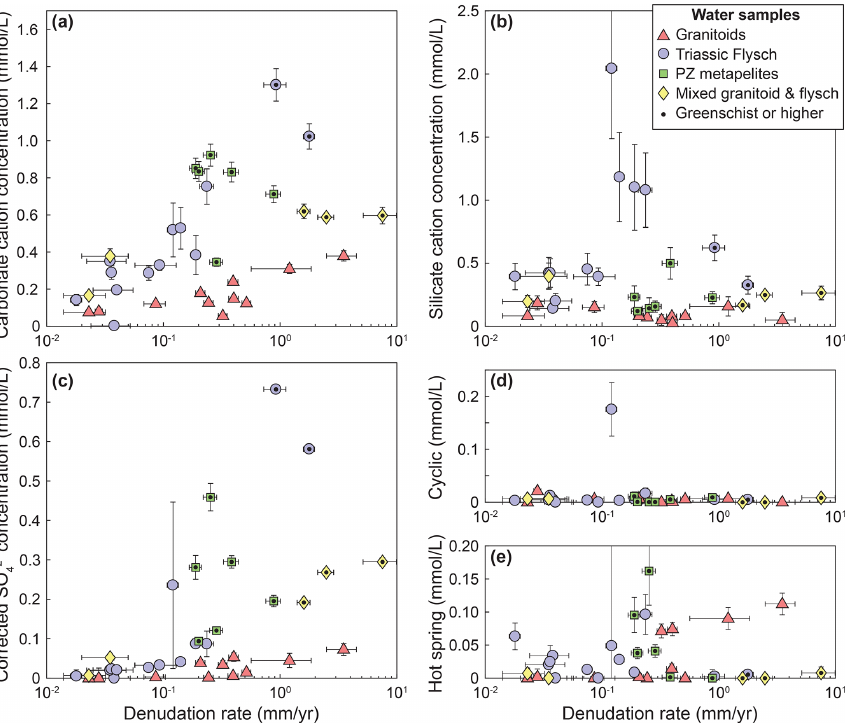
Figure 5. Unmixed contributions to the solute load. (a) Cation concentrations from carbonate weathering. (b) Cation concentrations from silicate weathering. (c) Sulfate concentrations corrected for precipitation and inferred to derive from sulfide oxidation. (d) Cation concentra- tions from cyclic sources. (e) Cation concentrations from hot spring sources. Catchments underlain by different lithologies are distinguished by symbols and color. Data points with a black dot are metamorphosed to greenschist facies or higher.